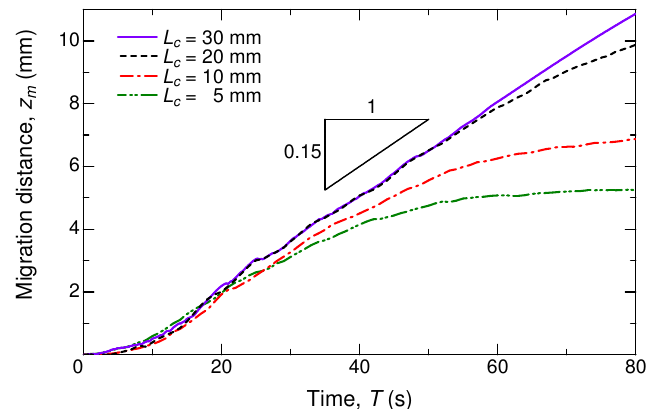
Figure 6. Time series of the migration distance of the liquid column for different liquid column lengths, without normalization. With R = 1.25 mm, N z = 350–600, and N r = 256.